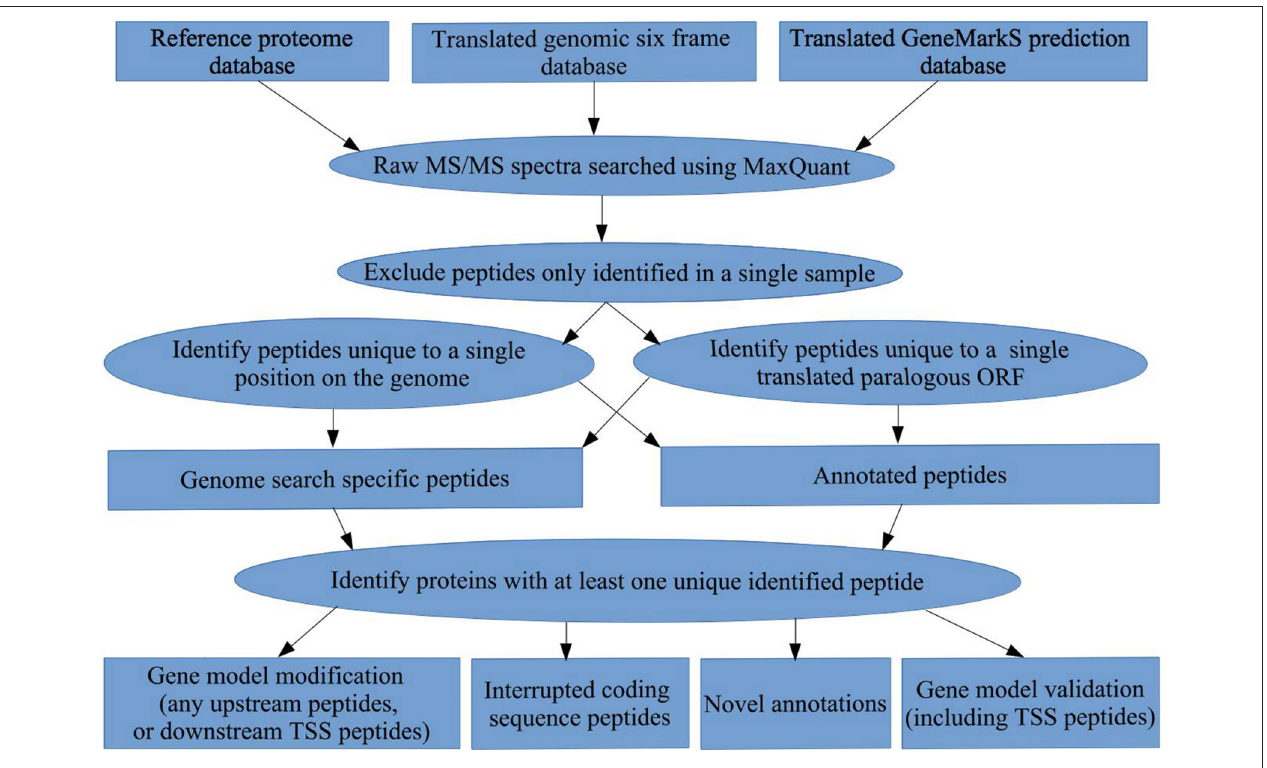
FIGURE 1 | Bioinformatics workflow. A summary of the proteogenomic pipeline applied to obtain gene model validations, gene model modifications, novel ORF annotations, and interrupted coding sequence identifications in M. smegmatis mc 2 155, using a translated genomic six frame database, a translated GeneMarkS gene prediction database, and the Reference